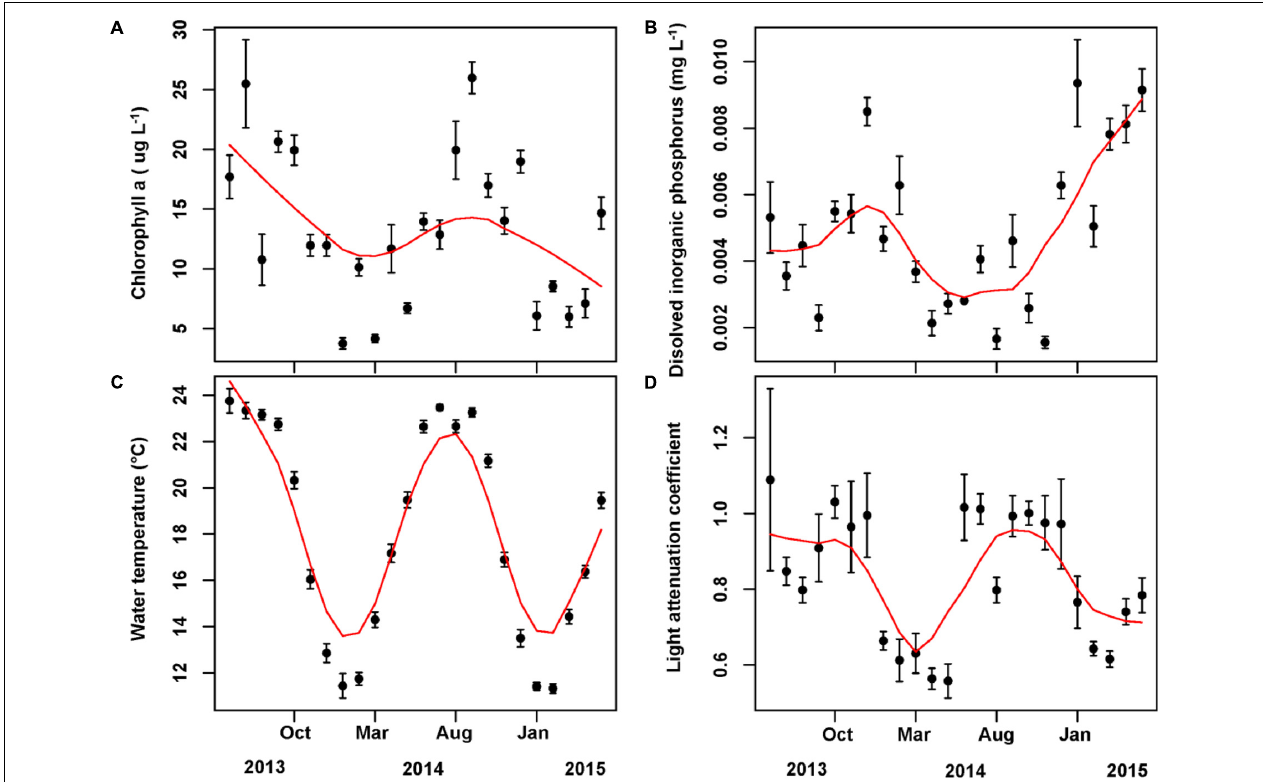
FIGURE 4 | Monthly time series of Chlorophyll a (A) , dissolved inorganic phosphorus (B) , water temperature (C) , and light attenuation coefficient (D) . The mean value and associated standard deviation among sites is shown in each panel.